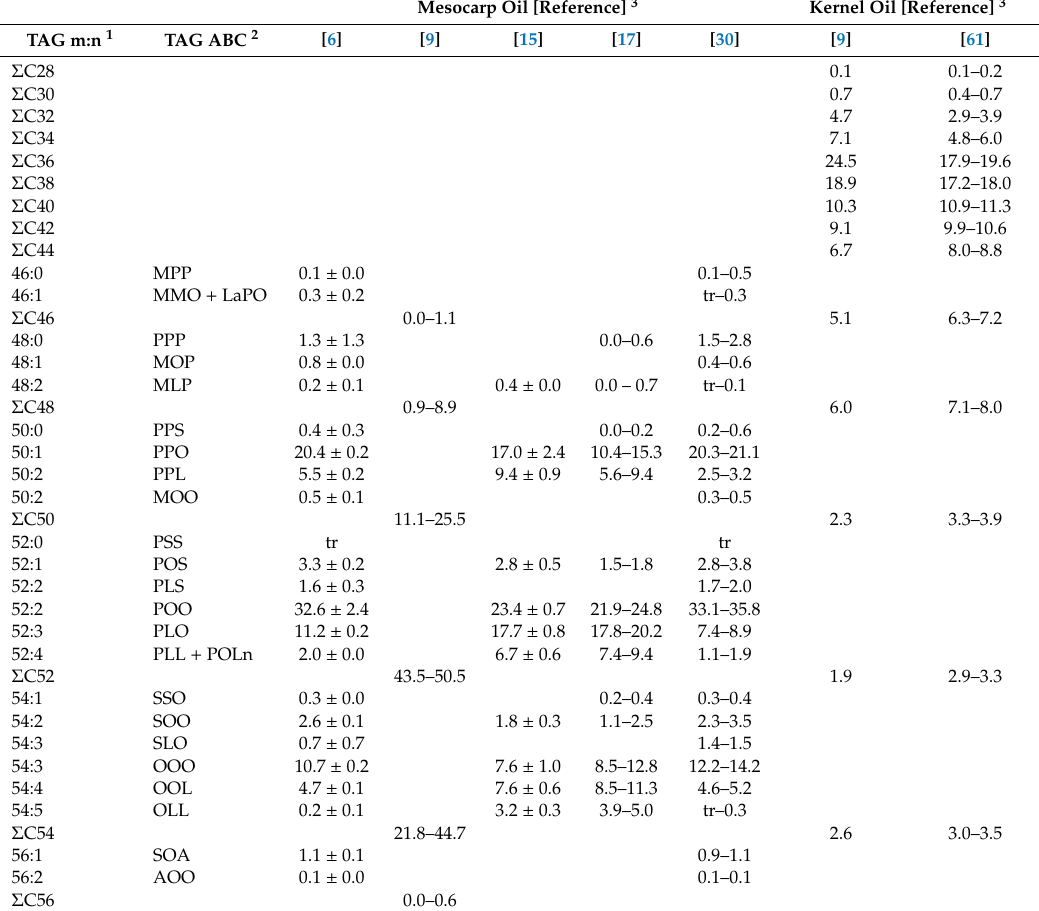
Table 3. Triacylglycerol (TAG) composition (% w / w ) of mesocarp and kernel oils from interspecific hybrid